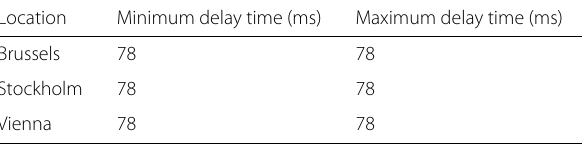
Table 3 Voice communication test result between